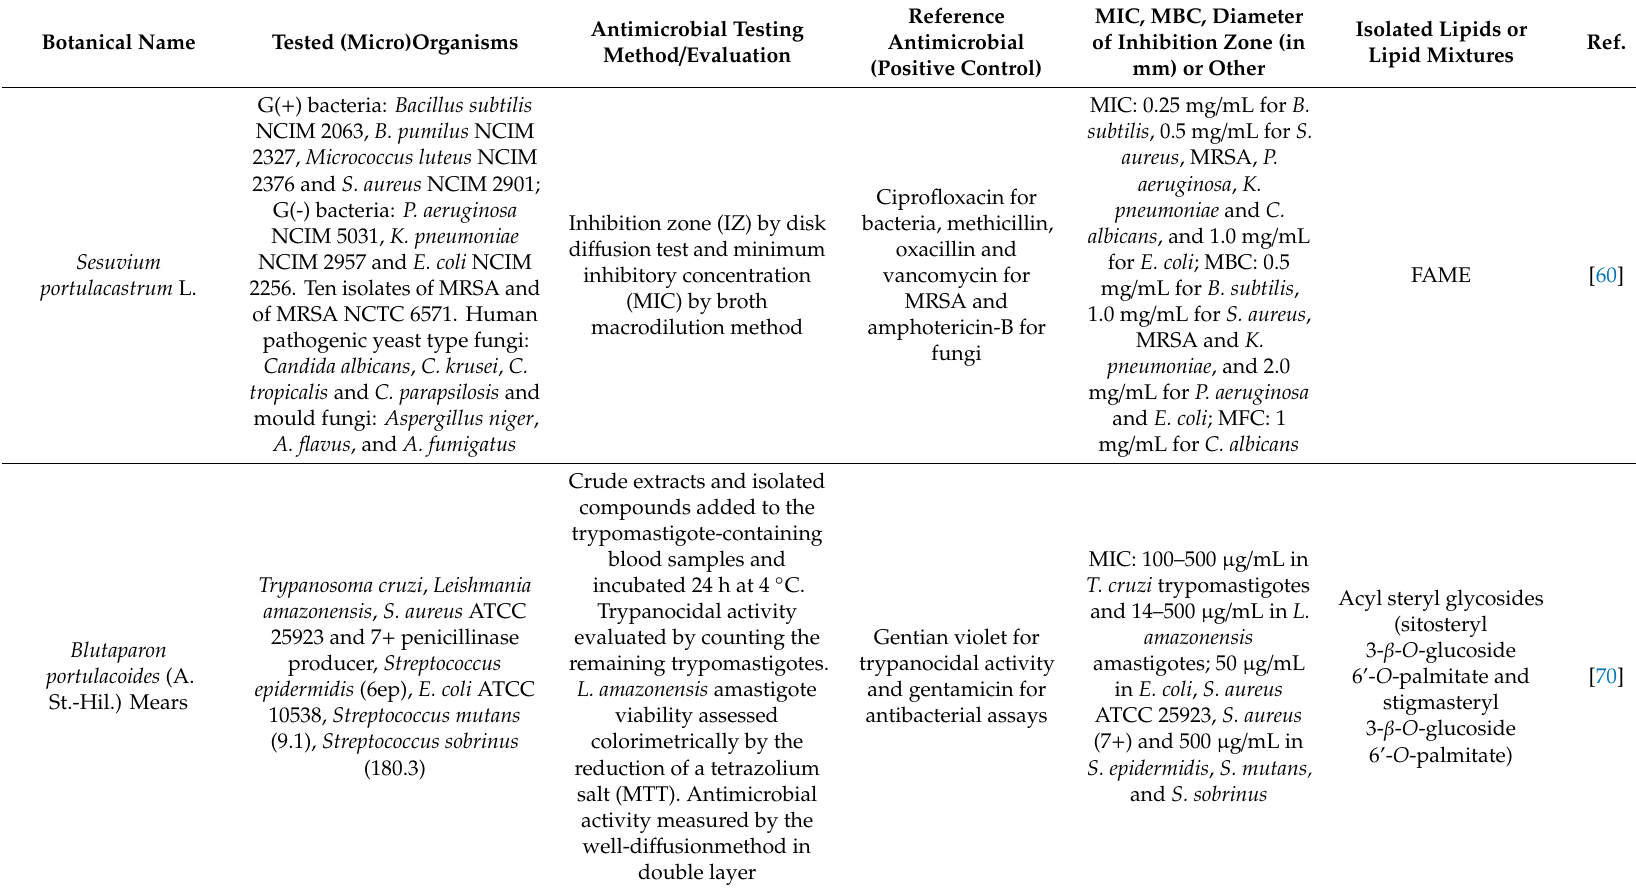
Table 2. Antimicrobial activity of plant lipids or plant lipid-rich